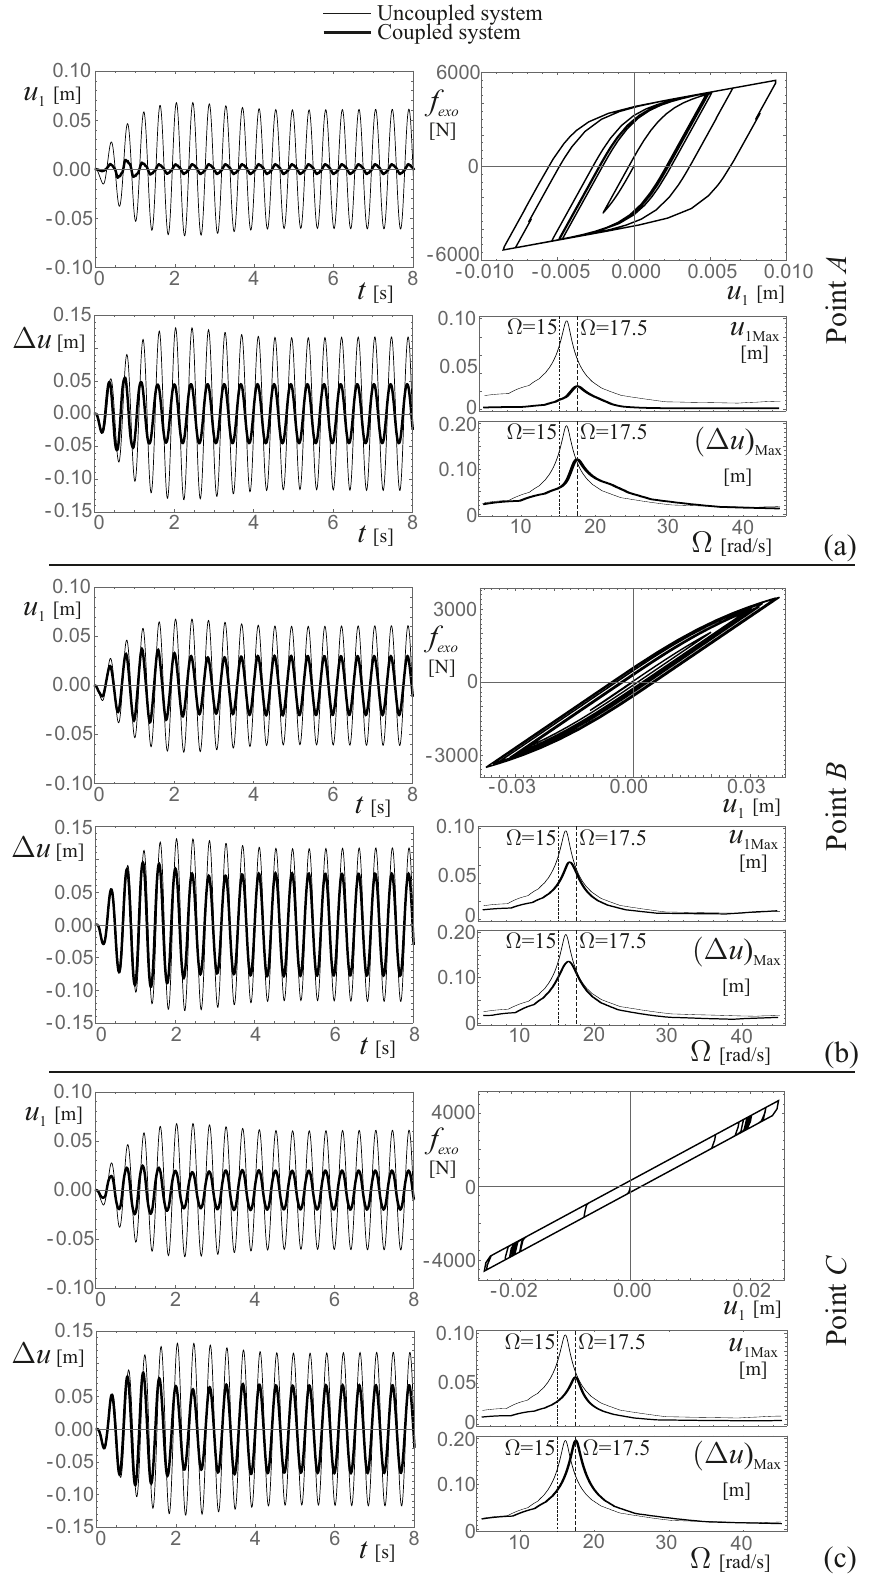
Figure 4. Time-histories, hysteretic cycles and frequency-amplitude curves: ( a ) Point A ; ( b ) Point B ; ( c ) Point C (points labelled in Figure 3b, ψ = 0.1, γ = 0.1, A s = 0.7 g m/s 2